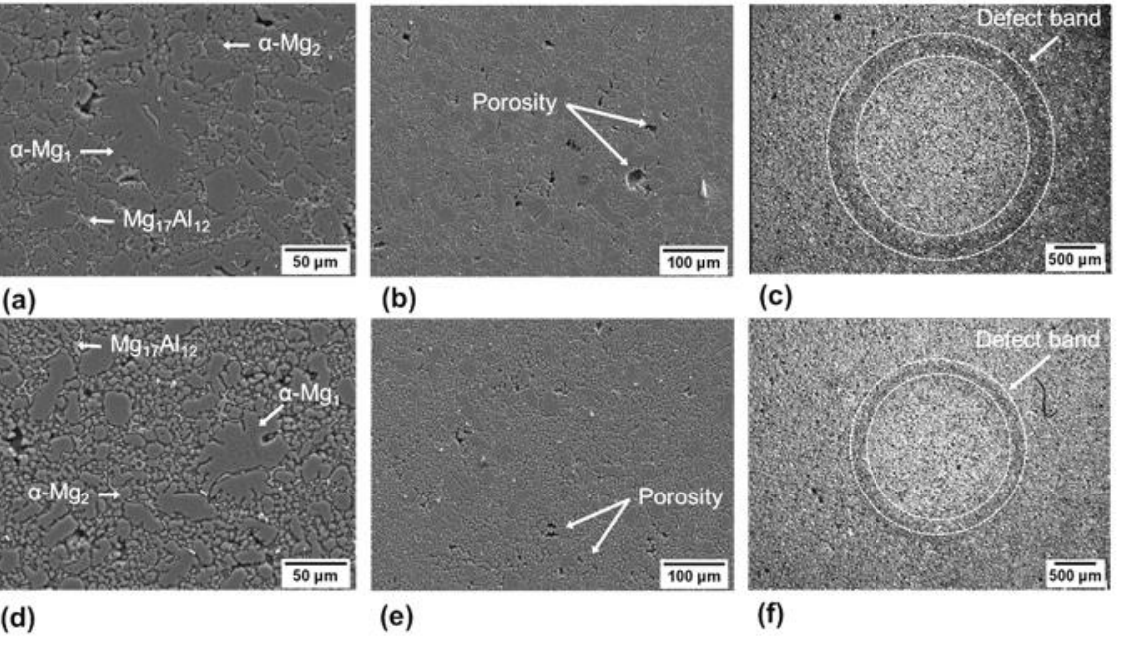
A phases, ( b , e ) porosity, and ( c , f ) 17 12